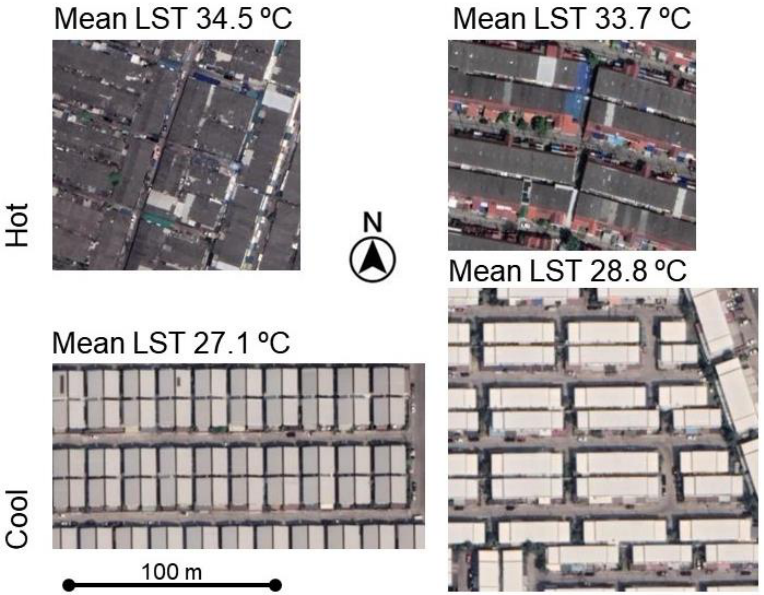
Figure 5. Second coolest/hottest (left) and third coolest/hottest (right) among the 62 residential areas. The images show the 2004 or before (top) and the 2013 or later (bottom) residential areas. The images were acquired in